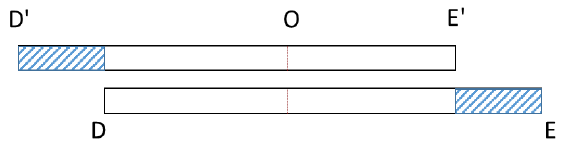
Figure 4. Pictorial representation of overlap between two convergent images